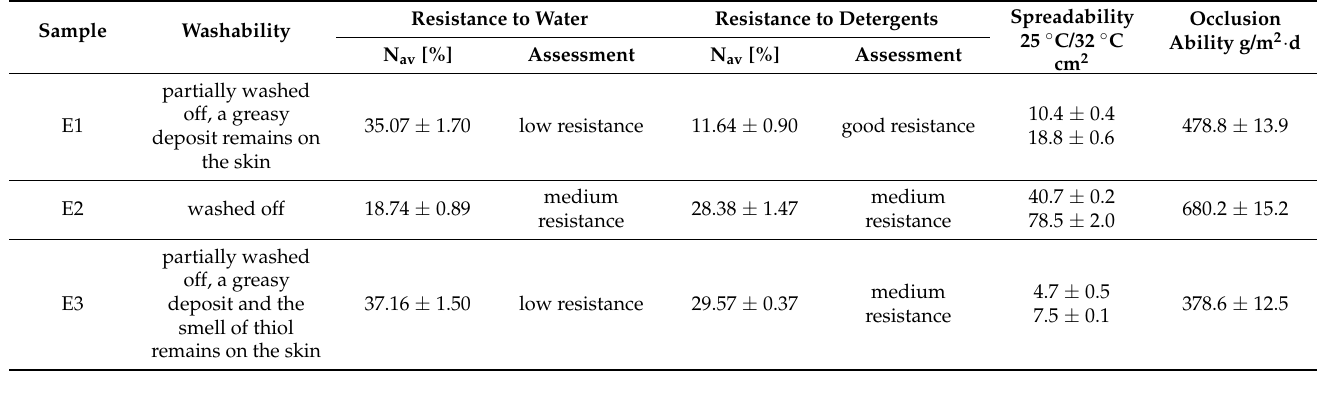
Table 6. Parameters determining the efficacy of samples E1–E3.